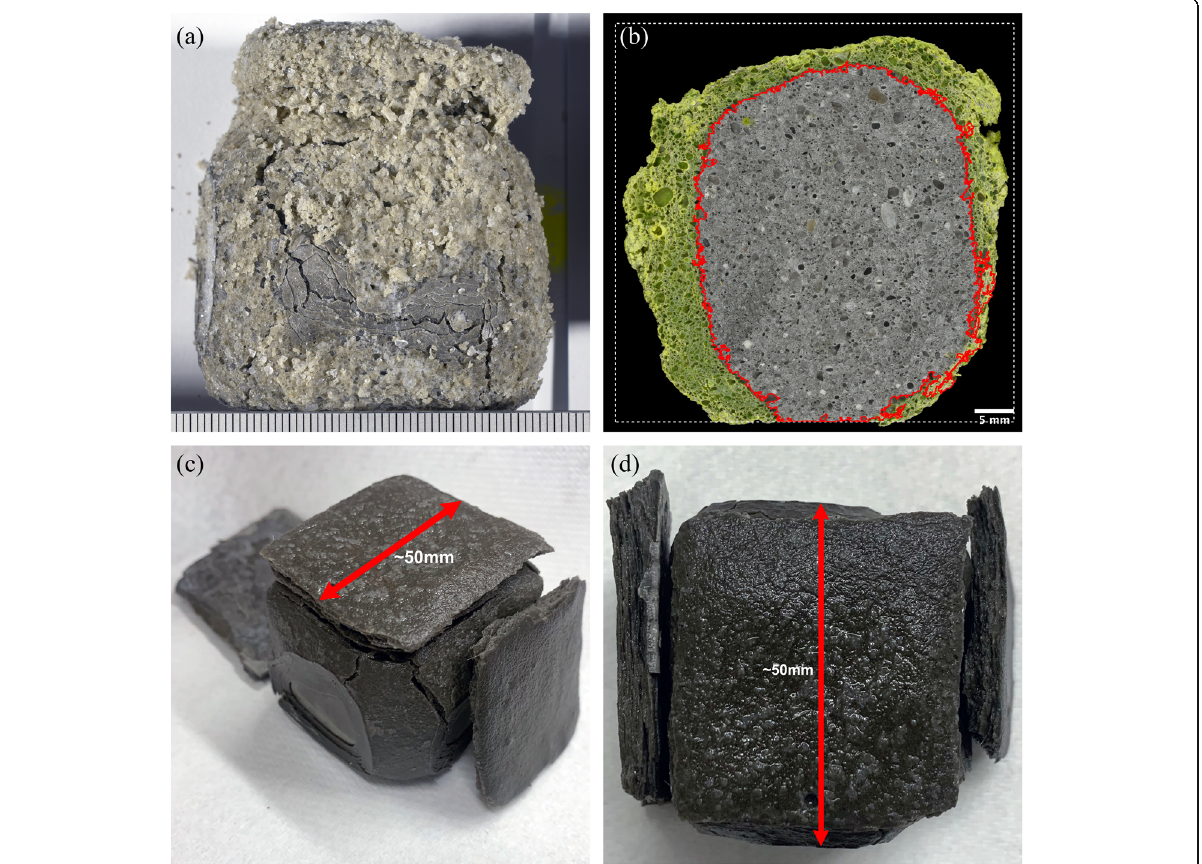
Fig. 3 a Photograph showing the condition of the lab-cast mortar after 142 freeze-thaw cycles under the submersion of a 25 wt.% CaCl 2 solution. Scale in millimeters. b Reflected light photomicrograph (RLP) of the polished surface of the lab-cast mortar. White square and red curve indicate the original size and the remaining intact zone of the sample, respectively. The yellow green color in ( b ) indicates the epoxied damage zone. c and d Photographs showing the condition of the lab-cast paste after 51 freeze-thaw cycles under the submersion of a 25 wt.% CaCl 2